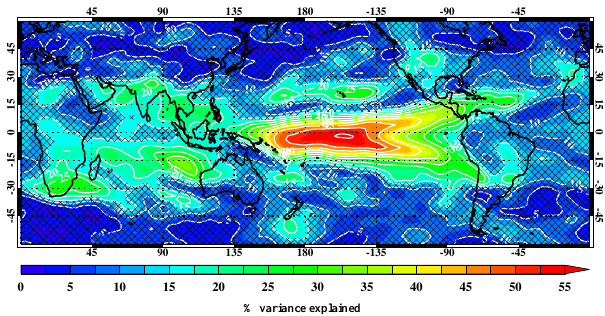
Figure 4. The TCO sensitivity to the Niño 3.4 index from the lin- ear regression over 2005–2013 (color contours). The sensitivity is expressed as the change in the TCO per degree change in the index (DUK − 1 ). Crosshatched regions denote where the sensitivity is not statistically different from zero at the 95% confidence level. White contours are incremented every 0.3DUK − 1 . The streamlines show the difference between the mean winds at 200hPa for months with strong El Niño conditions (Niño 3.4 index greater than 0.75) mi- nus months of strong La Niña conditions (Niño 3.4 index less than − 0.75). The thickness of the streamlines is scaled to the magnitude of the difference. Particularly note the midlatitude regions of neg- ative and positive sensitivity aligned with anomalous cyclonic and anticyclonic circulations, as discussed in the